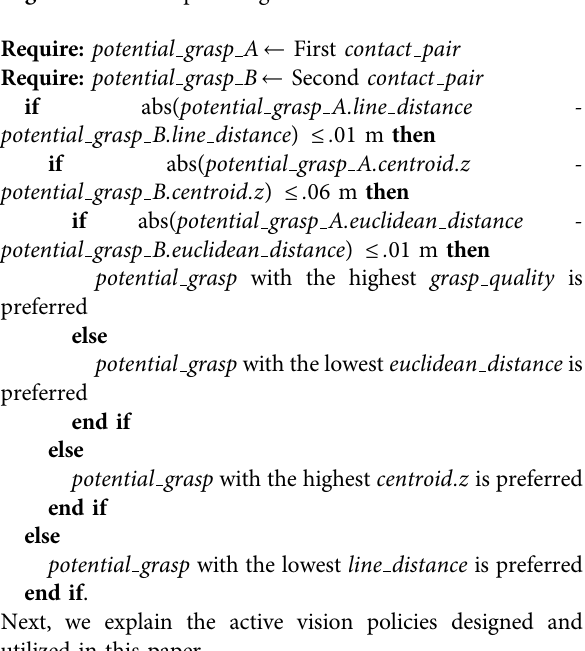
Algorithm 3: 2D Heuristic